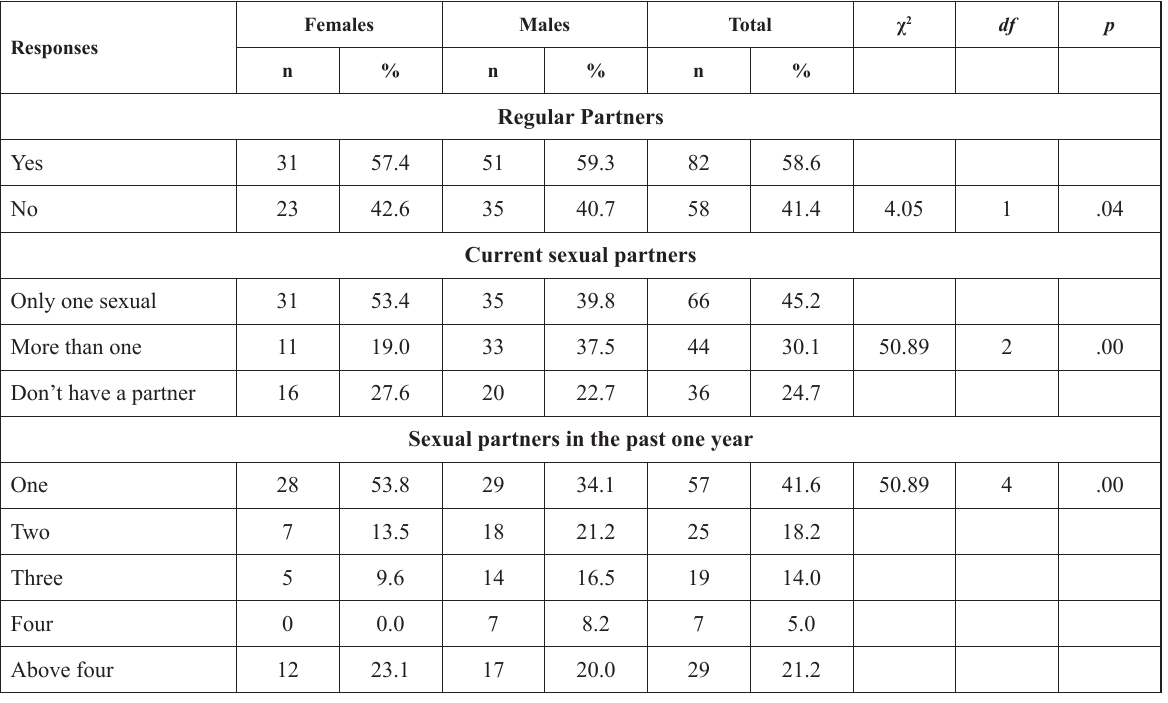
Table 3. Responses on regular sexual partners, current sexual partners and sexual partners in the past one year